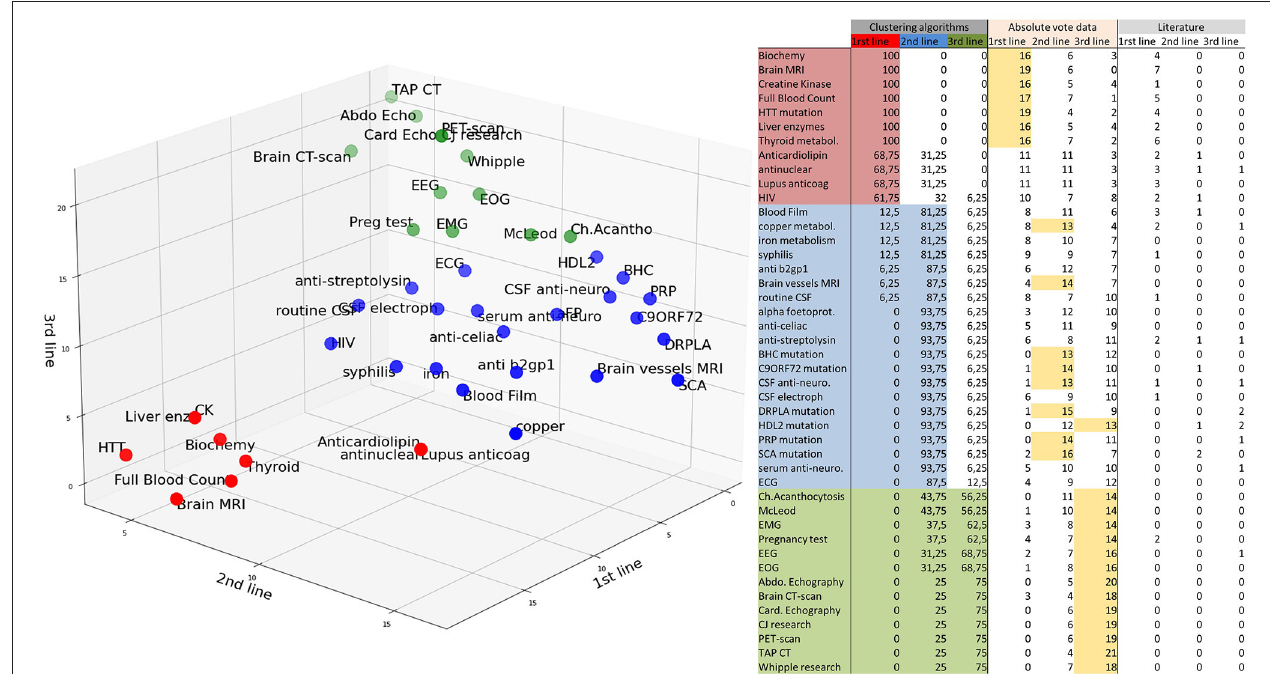
FIGURE 2 | Classification of the paraclinical tests. 1st-line: red, 2nd-line: blue, 3rd-line: green. The results of the clustering algorithms are summed in the left columns (results in % of runs of the algorithms). Absolute numbers of votes are reported in the middle columns as “Absolute vote data.” The majority vote ( > 50% of 25 votes) is highlighted in yellow. Literature results are summarized in the right columns. McLeod: exclusion of the McLeod Kell phenotype by a blood bank (weak Kell antigens and, if available, no reaction with anti-Kx). Ch.acanthocytosis: Western blot for chorein